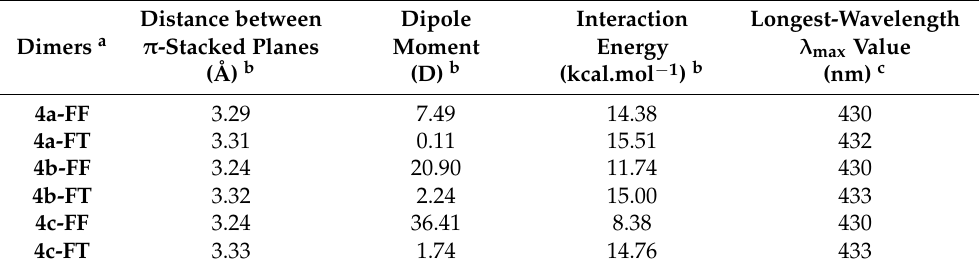
Table 5. Calculated properties of π -stacked dimers of 4a – c cations.